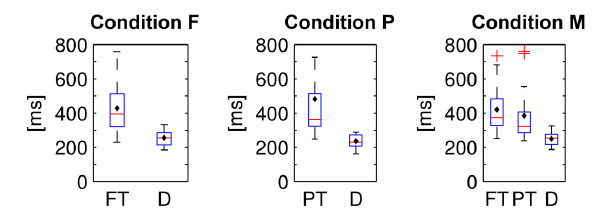
FIGURE 8 | Fixation durations of foveal (FT) and peripheral targets (PT) and distractors (D) in the three experimental conditions. Average values were computed per subject and displayed as box plots. Black diamonds indicate the respective mean over participants, red lines the median, blue boxes the 25th and 75th percentiles and whiskers the range—excluding outlier participants that are marked by red plus signs.